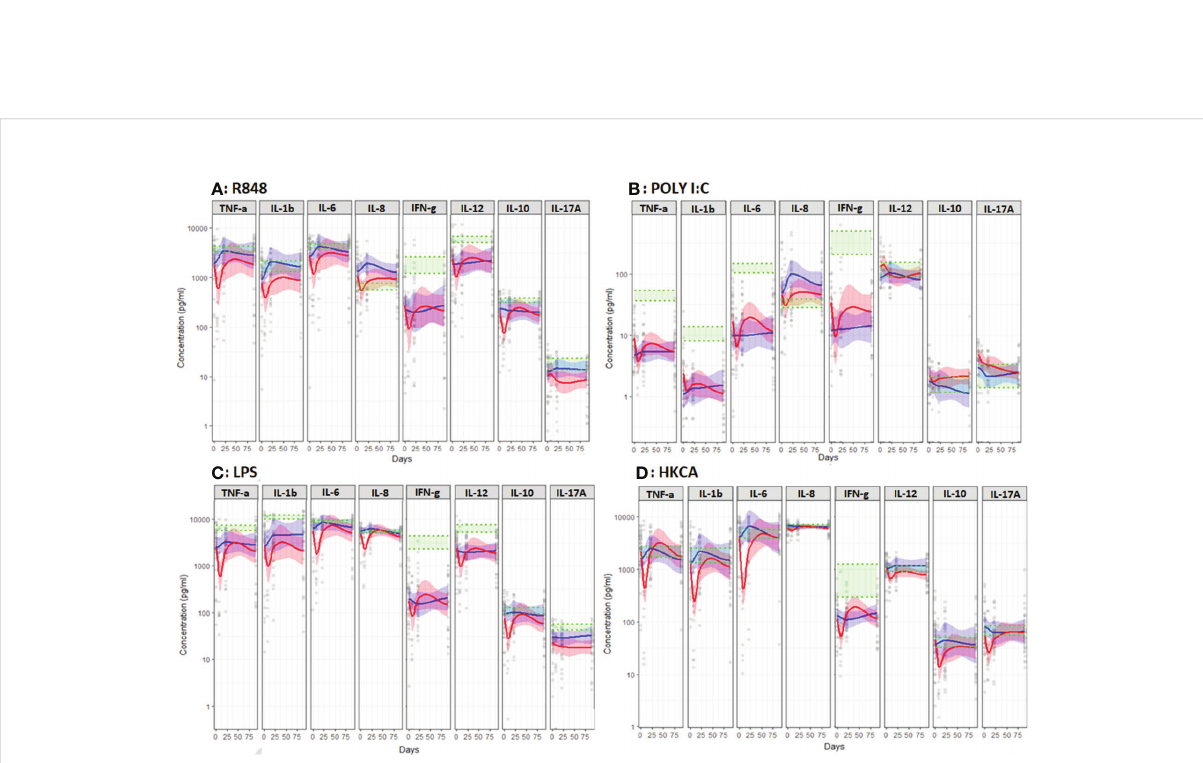
FIGURE 5 Induced immune response to different immune stimuli assessed by TruCulture ® in NSCLC patients during treatment with chemotherapy (CT, Red, n=24) or immunotherapy (ICI, Blue, n=13). (A) Resiquimod (R848), (B) polyinosinic:polycytidylic acid (poly I:C), (C) Lipopolysaccharide (LPS) and (D) heat-killed Candida albicans (HKCA). Corresponding 95% con fi dence interval shown as the light red respectively blue area. The shaded green area represents the in-house reference level (95% con fi dence interval between the green dotted lines).